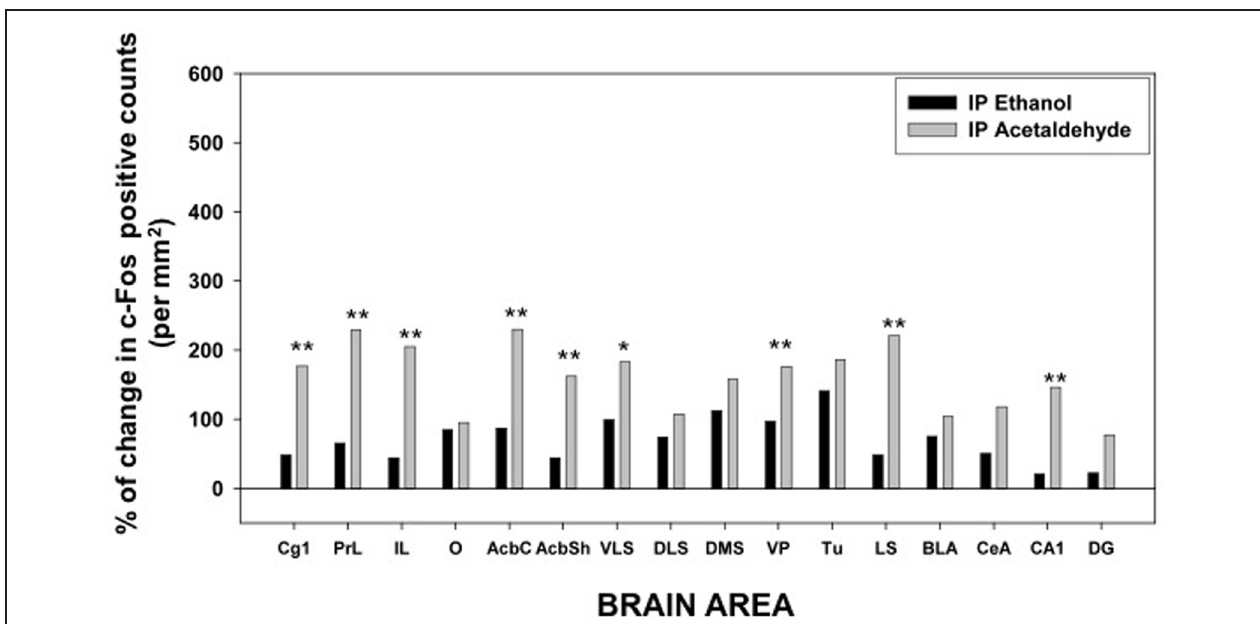
FIGURE 3 | Percentage of change in c-Fos counts after IP administration of ethanol and acetaldehyde (0.5g/kg) in relation to the saline vehicle group for every brain structure. ∗ p < 0 . 05, ∗∗ p < 0 . 01 different from EtOH in that brain area.